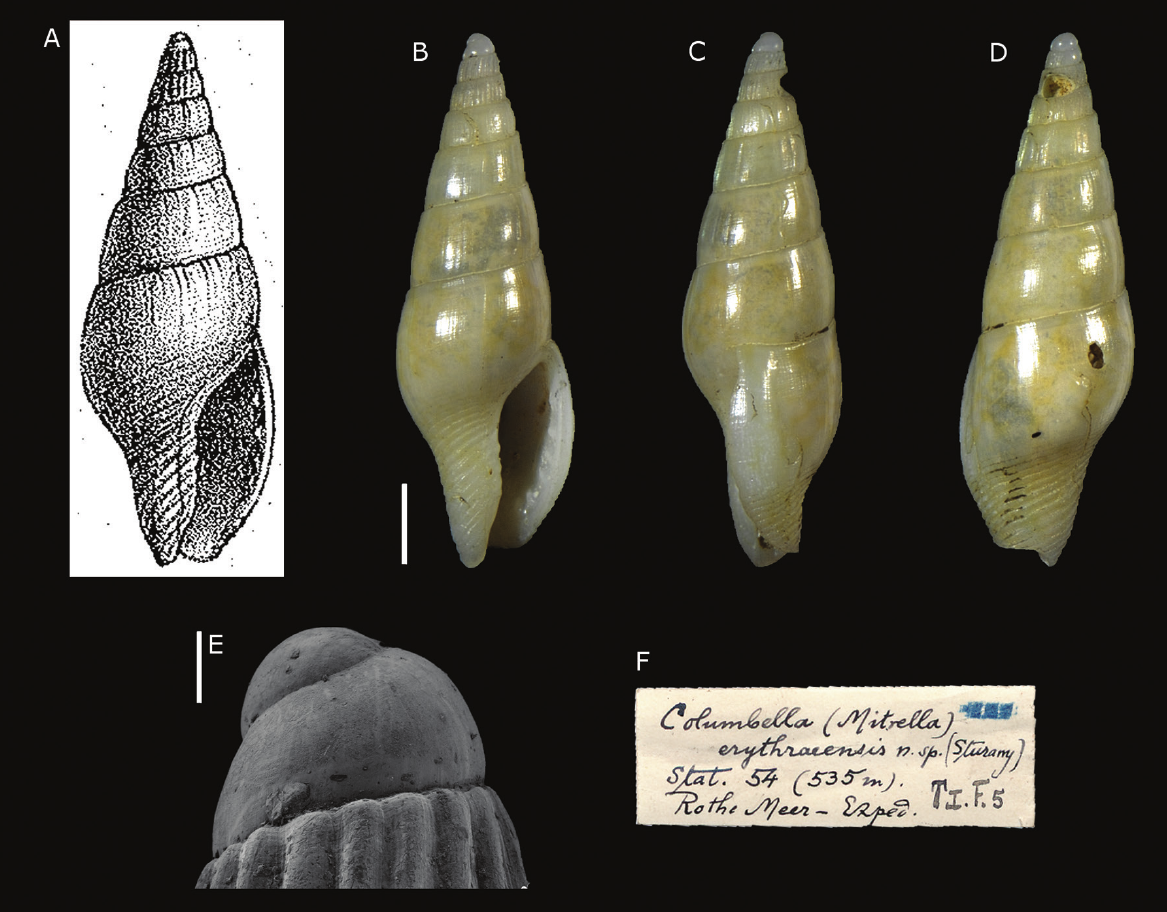
Figure 9. Columbella erythraeensis Sturany, 1900, Station 54 (Central Red Sea). A . Original figure by Sturany (1903). B–E . Holotype, NHMW 84221: front ( B ), right side ( C ), back ( D ), protoconch ( E ). F . Original holotype label. Scale bars: B–D : 2 mm, E : 0.2 mm.